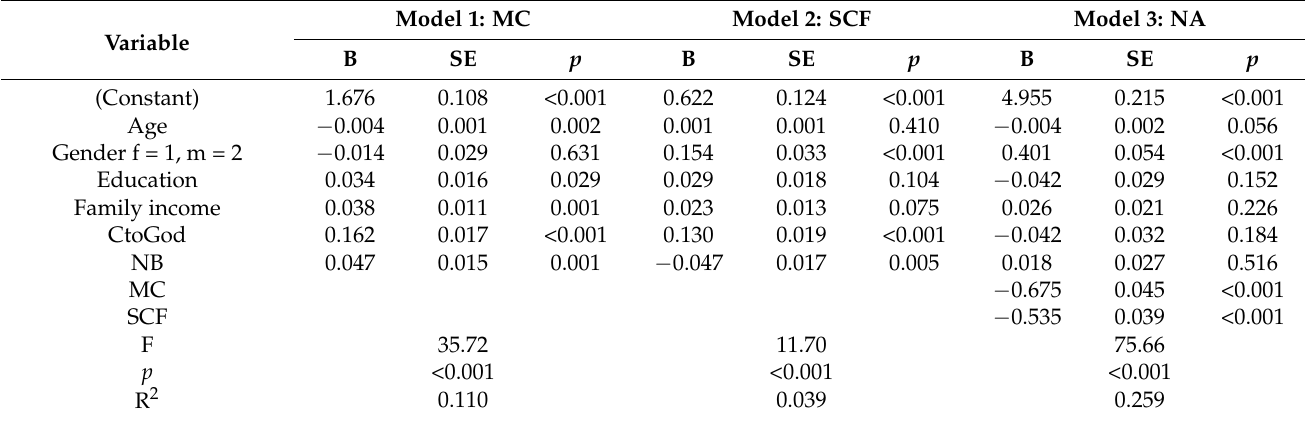
Table 3. Main regression effects on MC, SCF, and NA.